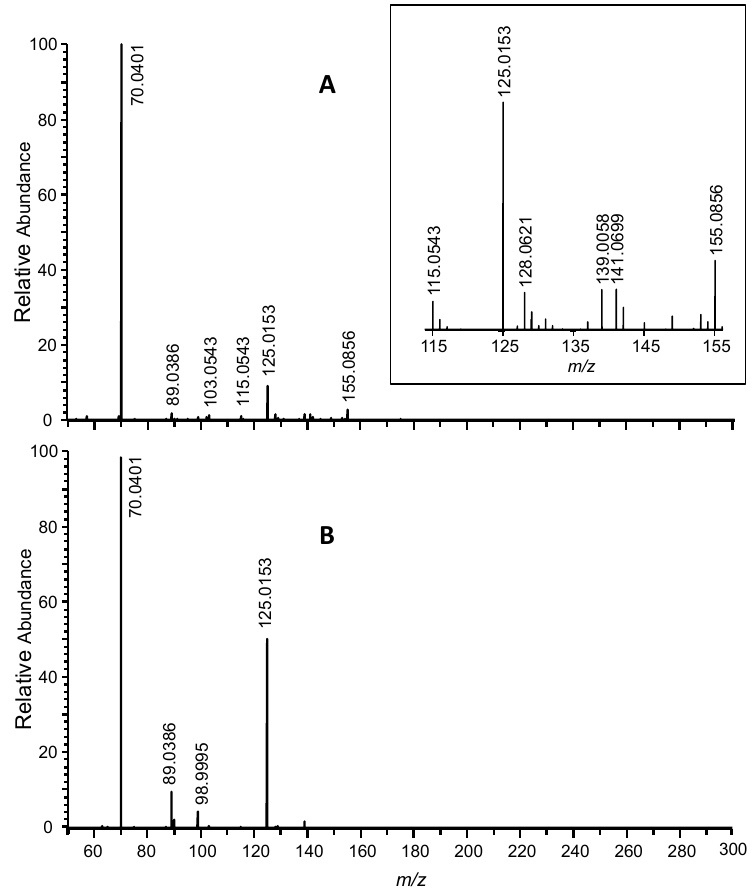
Figure 4. Positive ESI spectra obtained with an NCE 90 eV for: ( A ) uniconazole, with insert expanding the mass range between 115 and 155, and ( B ) cyproconazole.